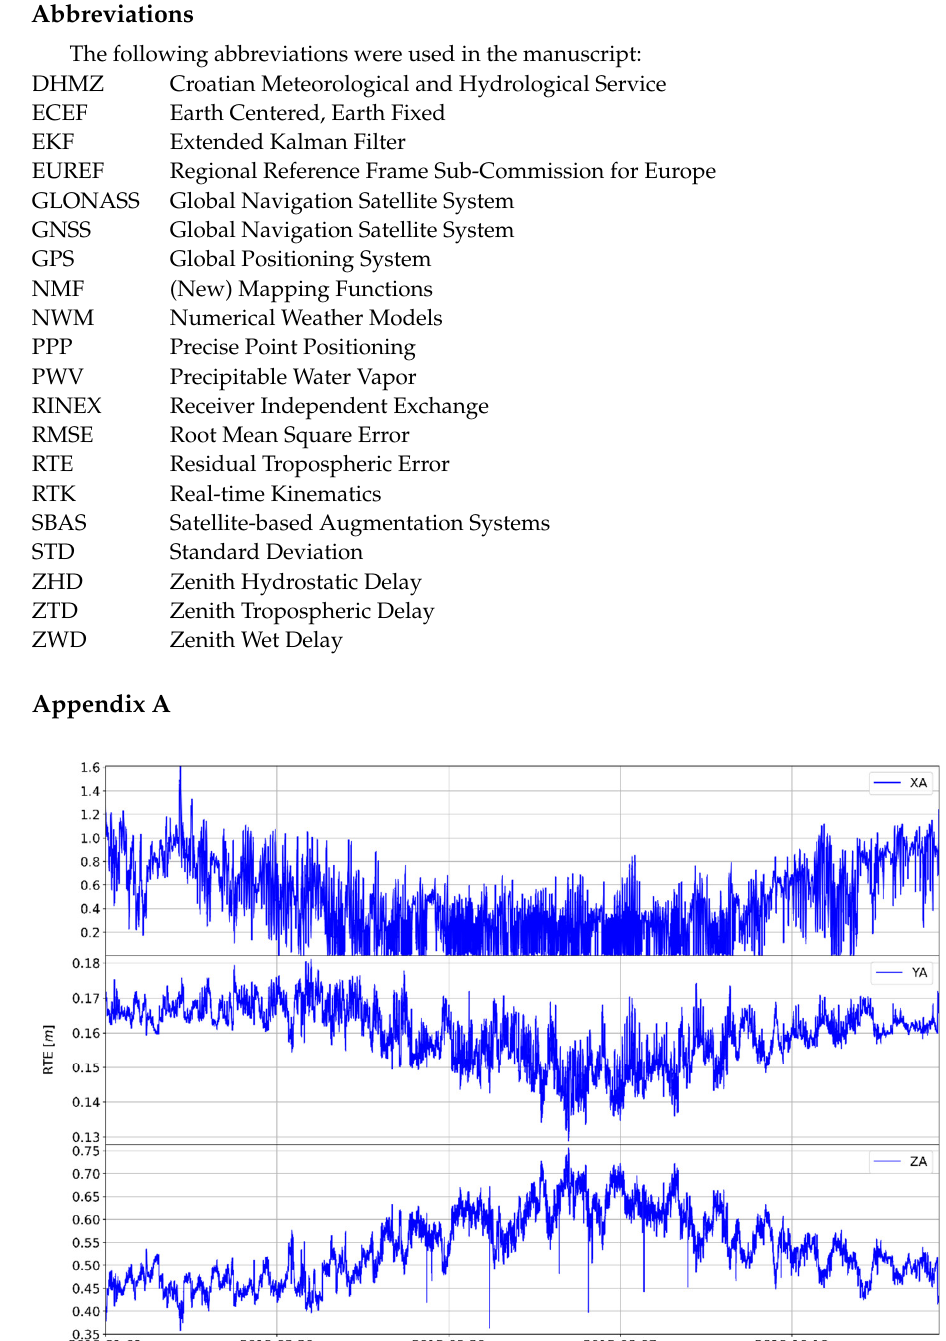
Figure A2. Movement of the absolute difference of the RTE GNSS Zadar position parameter in 2015.